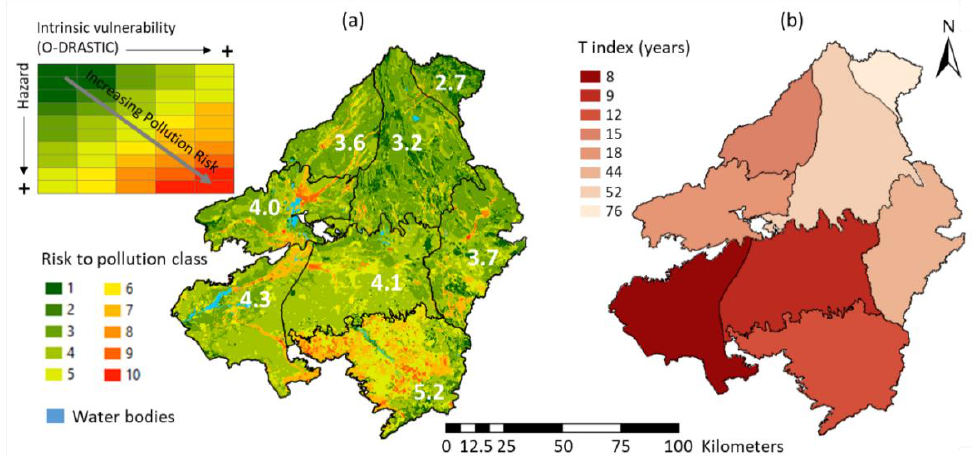
Figure 5. ( a ) Pollution risk map (numbers indicate the L-RISK index for each aquifer) and ( b ) lumped mean residence time map in the historical period.